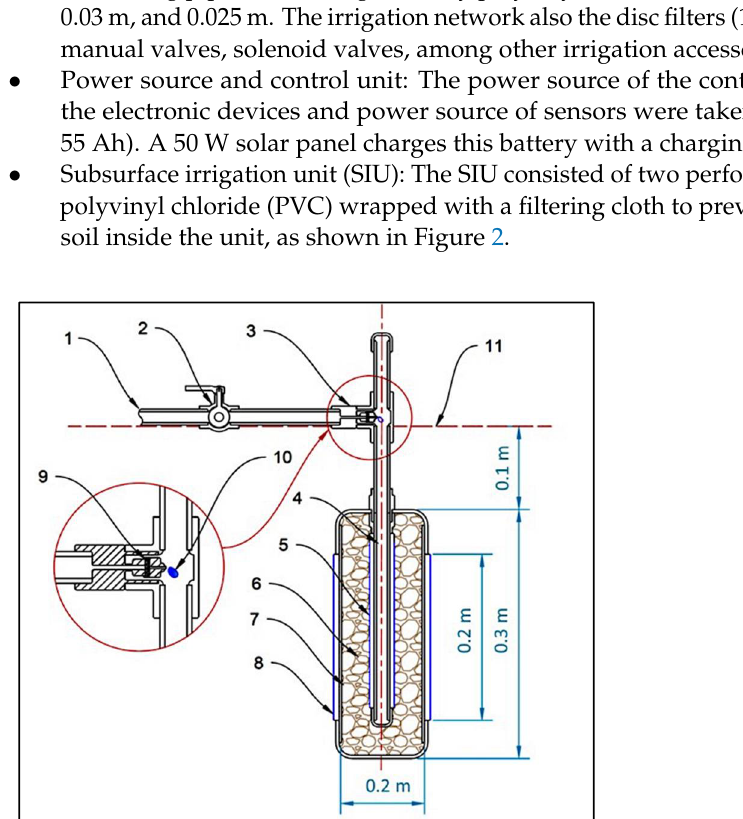
Figure 2. Schematic diagram of the designed subsurface irrigation unit used in the controlled subsurface irrigation system (dimensions in m). (1) Water source, (2) Manual valve, (3) Water flow regulator, (4) Perforated inner pipe, (5) Filtering cloth of the inner pipe, (6) light volcanic gravel, (7) Slotted outer pipe, (8) Filtering cloth of the outer pipe, (9) Twistable dripper head, (10) Water droplet, (11) Ground level.